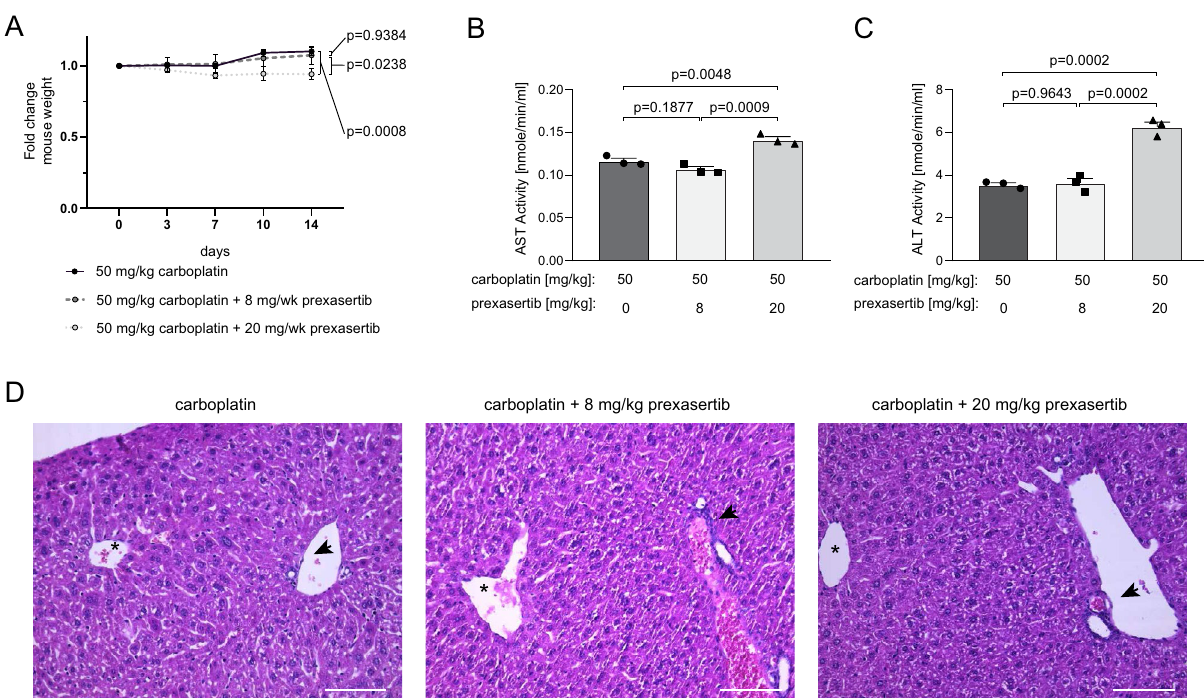
Figure 5. A low dose of prexasertib in combination with carboplatin is well tolerated by mice. Healthy NMRI nude mice treated weekly with carboplatin (50 mg/kg) in combination with either vehicle, low dose (8 mg/ kg) or high dose (20 mg/kg) of Prexasertib for two weeks (N = 3). ( A ) Relative weight of the mice. Data are shown as Mean ± SEM. P values were determined by two-way ANOVA with Geisser–Greenhouse and Tukey’s corrections. ( B,C ) serum activity of the AST ( B ) and ALT ( C ) liver enzymes. Data are shown as Mean ± SEM. P values were determined by ordinary one-way ANOVA with Tukey’s correction. ( D ) H&E stainings showing livers of mice treated with the indicated combinations. The images show a terminal vein surrounded by normal liver architecture consisting of plates of hepatocytes one cell thick, separated by normal-looking sinusoids. No microabscesses, nor confluent areas of necrosis or inflammation were noticed around the terminal vein, nor around the portal spaces. Only sporadic isolated apoptotic hepatocytes were observed in all the specimens, and not in relation to a particular functional zone of the liver parenchyma. Asterisks denote terminal veins. Arrowheads denote portal tracts. Scale bar, 100